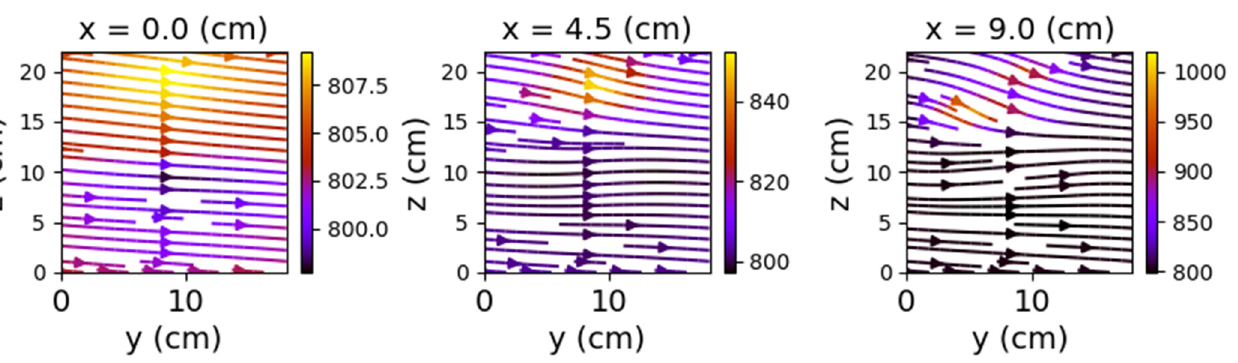
Figure 12. Field lines for y O z plane—relay with both coils powered. Closing the relay using only one of the coils also produced a noticeable change in the field lines. Again, the y O z and x O z plans revealed the most obvious changes. Figures 15–20 present the results obtained for only one coil powered (1–3 and, re- spectively, 2–4).